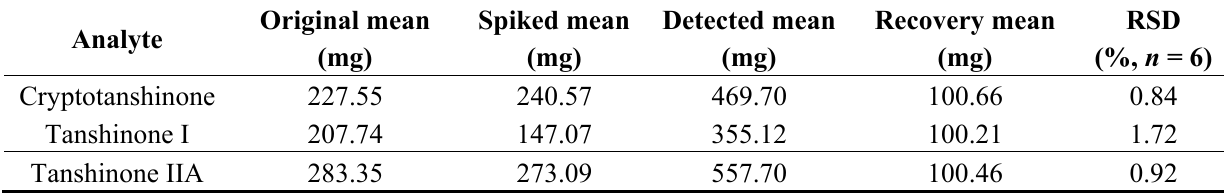
Table 7. Recovery of the three compounds in S. miltiorrhiza